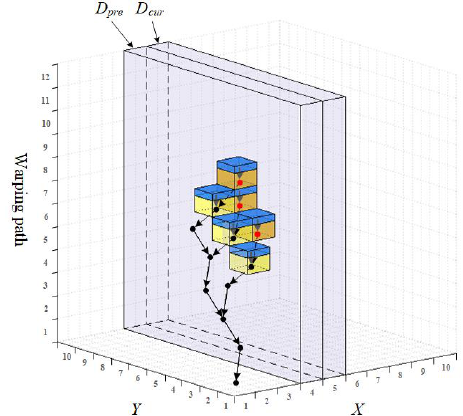
Figure 5. Illustration of the AM and ECT.